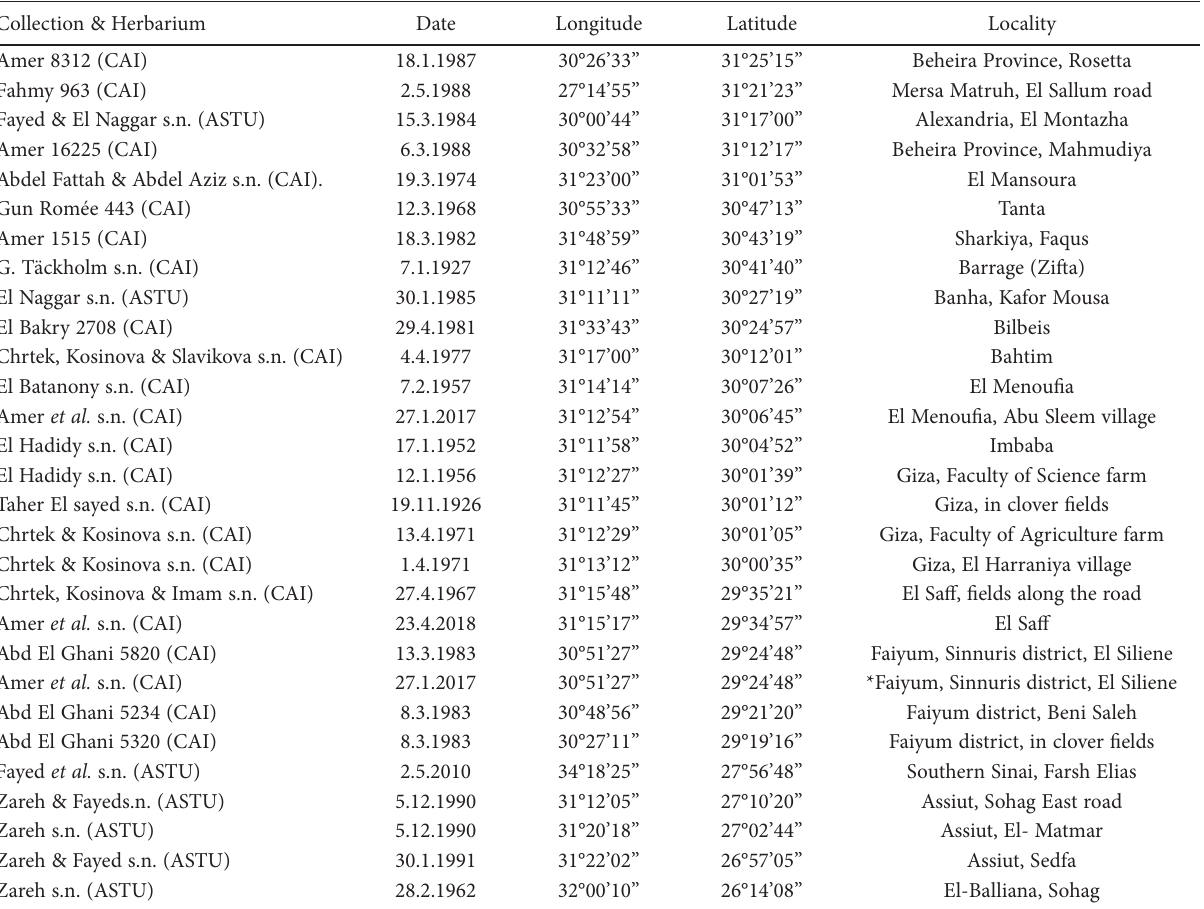
Table 1. Collected specimens of Capsella bursa-pastoris (L.) Medik. in Egypt with their geographical distribution (arranged from North to